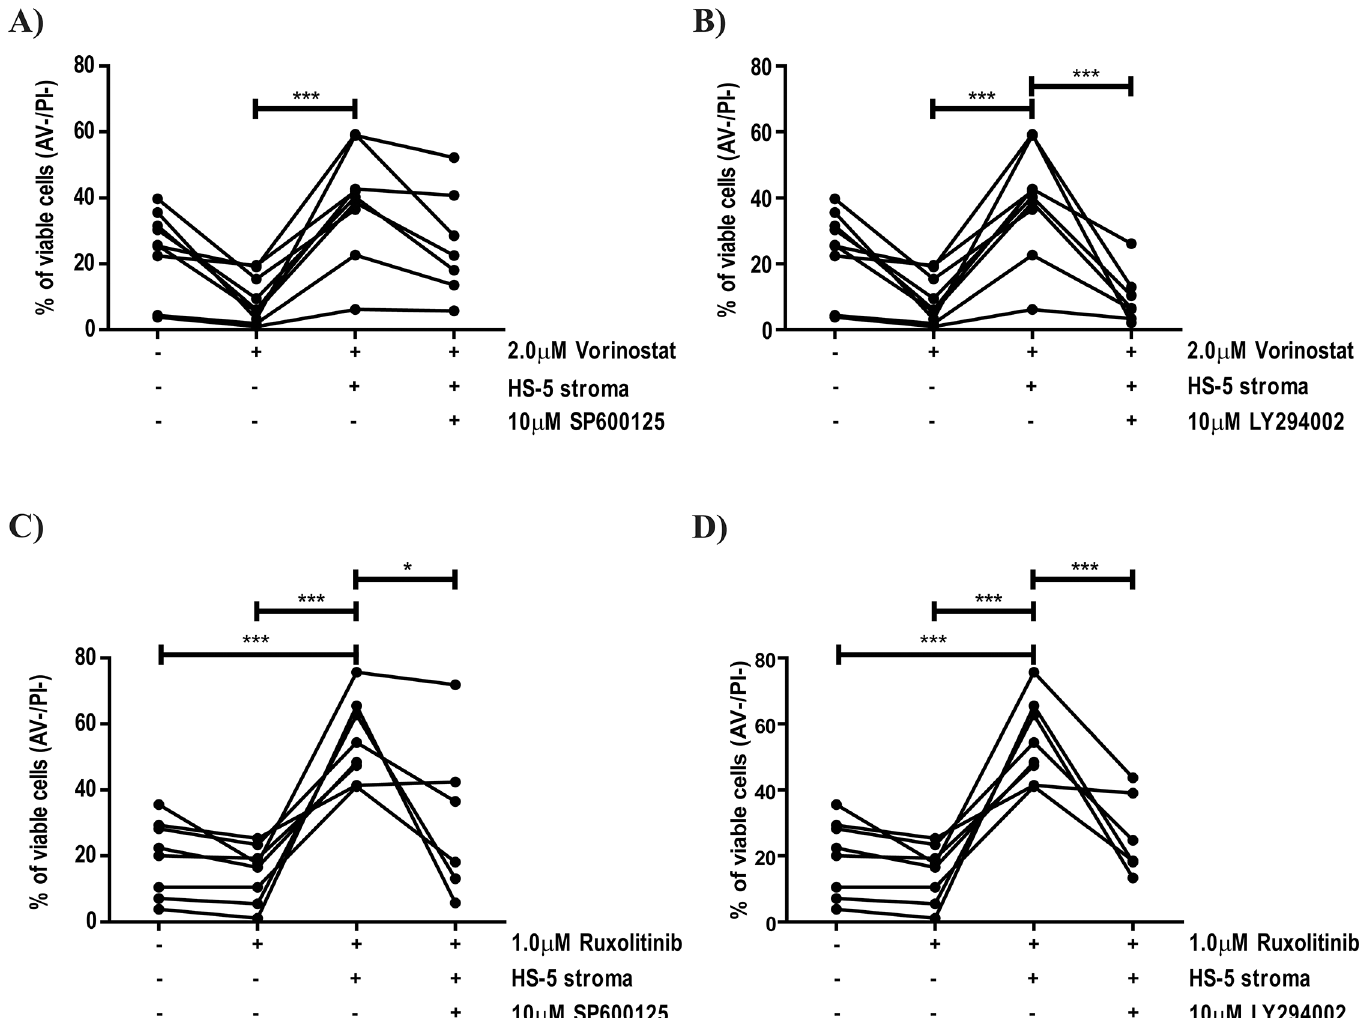
Fig 4. Pharmacological inhibition of JNK and PI3K signalling pathways abrogate the HS-5 BM stroma induced protection of patient derived BM Lin - CD34 + cells from Vorinostat – induced cytotoxicity. Lin - CD34 + cells were isolated as described in “ Material and Methods ” section and co-cultured in a stromal layer of HS-5 cells for 72h in presence of the indicated concentrations of Vorinostat (A and B), Ruxolitinib (C and D) SP600125 (JNKi – A and C) and LY294002 (PI3Ki – B and D). At 72h of co-culture, cells were harvested, stained with CD45 (to distinguish between Lin - CD34 + and HS-5 cells) and Annexin-V/ PI to determine cellular viability by Flow Cytometry analysis as described in “ Materials and Methods ” . The results are representative of nine MPN patients tested and graphics indicate the percentage of viable cells (Annexin-V and PI negative cells) in the indicated conditions ( * 0.05 > p; *** 0.001 >